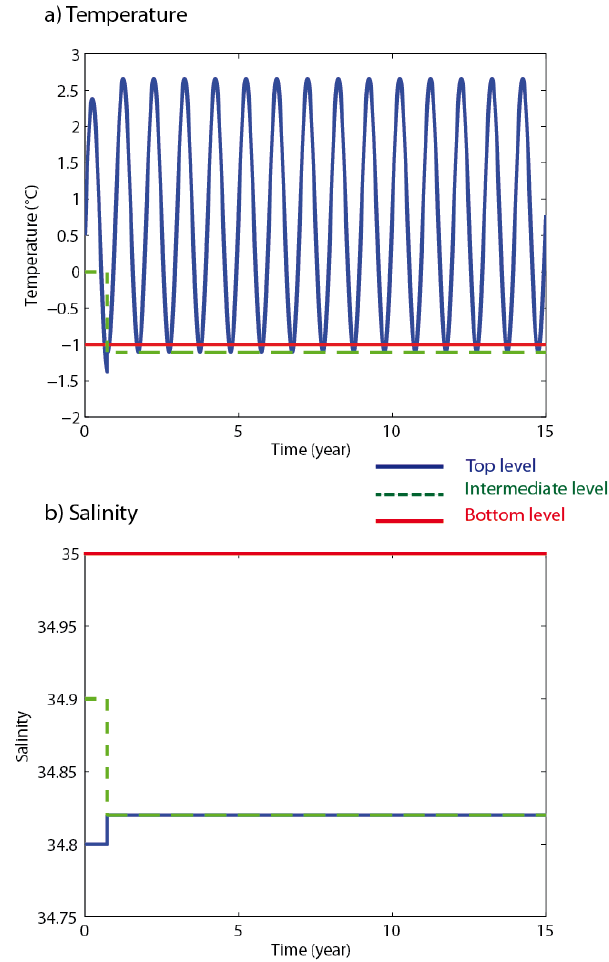
Fig. 7. (a) Temperature ( ◦ C) and (b) salinity in an experiment per- Figure 7. a) Temperature (°C) and b) salinity in an experiment performed with the three-level model formed with the three-level model initialized from a weakly strati- initialized from a weakly stratified state. The value of the top level is in blue, the intermediate level in fied state. The value of the top level is in blue, the intermediate level green and the bottom one is in red. In this configuration, the top two levels interact every winter and in green and the bottom one is in red. In this configuration, the top no ice is formed. two levels interact every winter and no ice is formed.